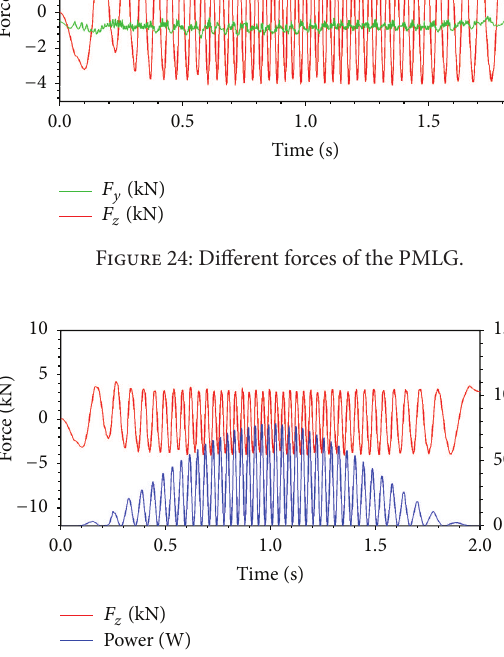
Figure 22: Magnetic flux linkage and terminal voltage.